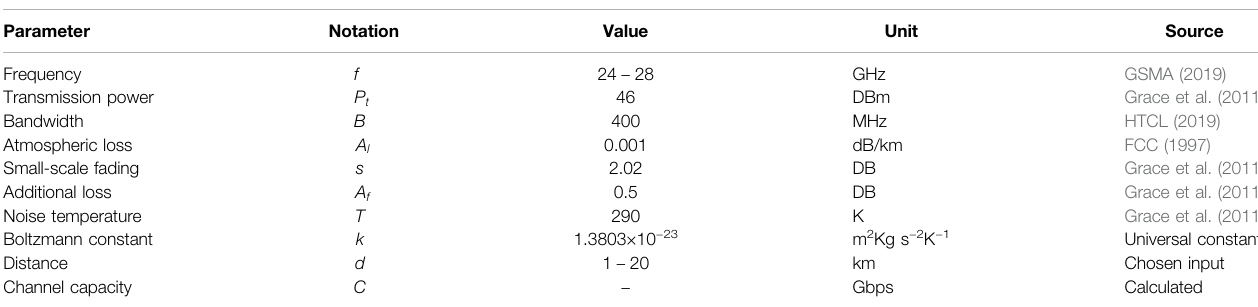
TABLE 1 | Channel model